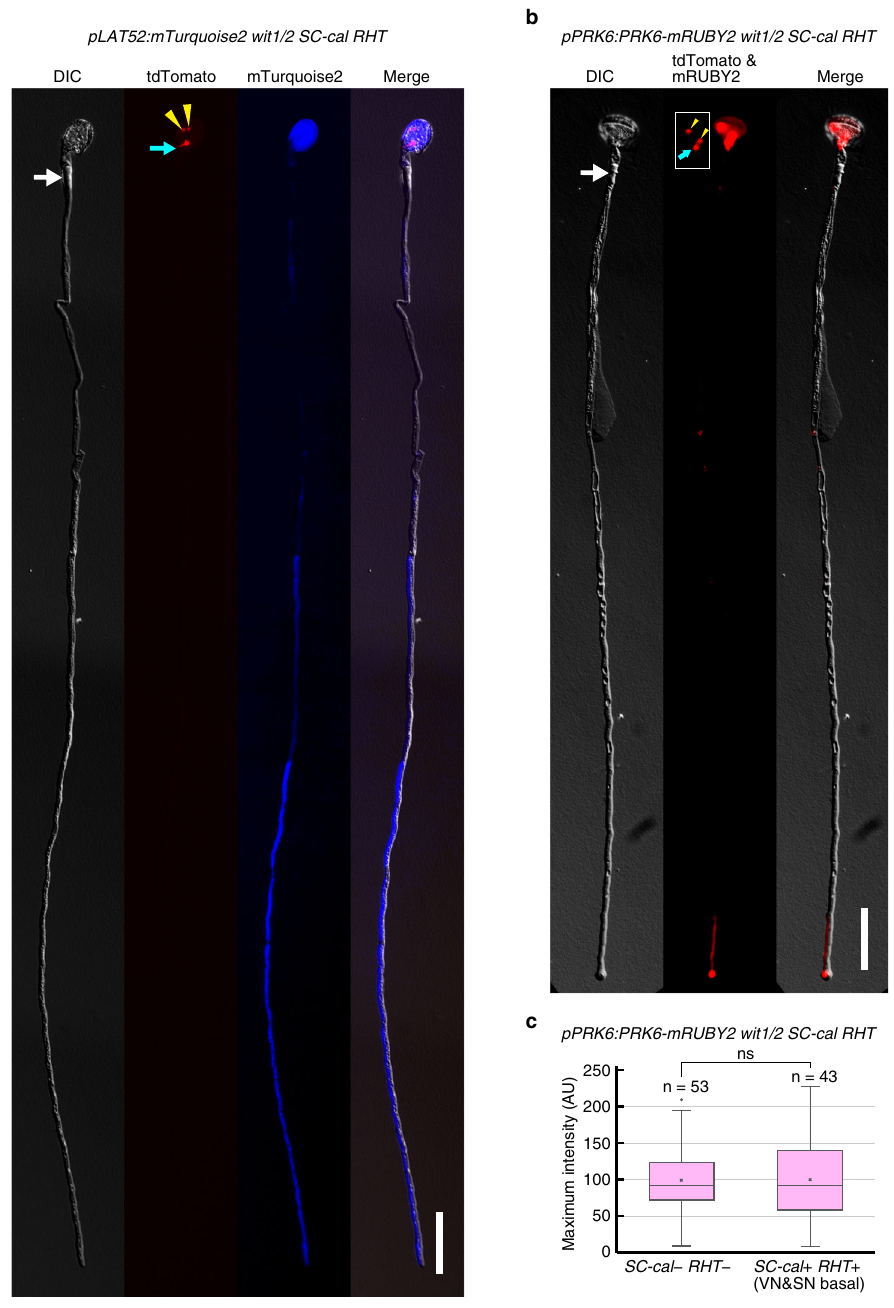
Fig. 7 Detection of vegetative cell-speci fi c reporter proteins in anuclear apical region. a , b Pollen tubes expressing mTurquoise2 ( a ) or PRK6-mRUBY2 ( b ) that contained immotile sperm cells and vegetative nucleus in the basal area of those pollen tubes. Pollen from the wit1 wit2 double mutant hemizygous for genetically linked pHTR10:cals3m ( SC-cal ) and pRPS5A:H2B-tdTomato (RHT), also hemizygous for the pLAT52:mTurquoise2 ( a ) or pPRK6:PRK6-mRUBY2 ( b ), were incubated on pollen-tube growth medium. To observe the long pollen tube in a single focal plane, pollen tubes containing immotile nuclear triplet were dragged out and transferred to fresh medium using a needle under a fl uorescence stereomicroscope 8 h after germination and then observed under an epi fl uorescence microscope. Representatives of 20 and 15 pollen tubes with similar patterns are shown in ( a ) and ( b ), respectively. Inset in ( b ) represents tdTomato-labeled sperm nuclei and vegetative nucleus captured at shorter exposure time (3 s). c Box-and-whisker plot of PRK6-mRUBY2 signal in pollen tubes from the pPRK6:PRK6-mRUBY2 wit1/2 SC-cal RHT plant that was also shown in ( b ). At 8 h after germination, the maximum intensity of the red fl uorescence was analyzed at the tip of pollen tubes expressing PRK6-mRUBY2. Box-and-whisker plots show median (center line), mean (cross mark), upper and lower quartiles (box), maximum and minimum (whiskers), and outlier (circle). A two-tailed Student ’ s t -test indicated no signi fi cant difference between the anuclear pollen tube that left three tdTomato-positive nuclei in the basal region ( SC-cal + , RHT + VN&SN basal) and the tdTomato-negative control pollen tubes ( SC-cal − , RHT − ) ( P = 0.773). Yellow arrowheads, cyan arrows, and white arrows represent the sperm nuclei, vegetative nuclei, and fi rst callose plugs, respectively. Scale bar: 50 μ